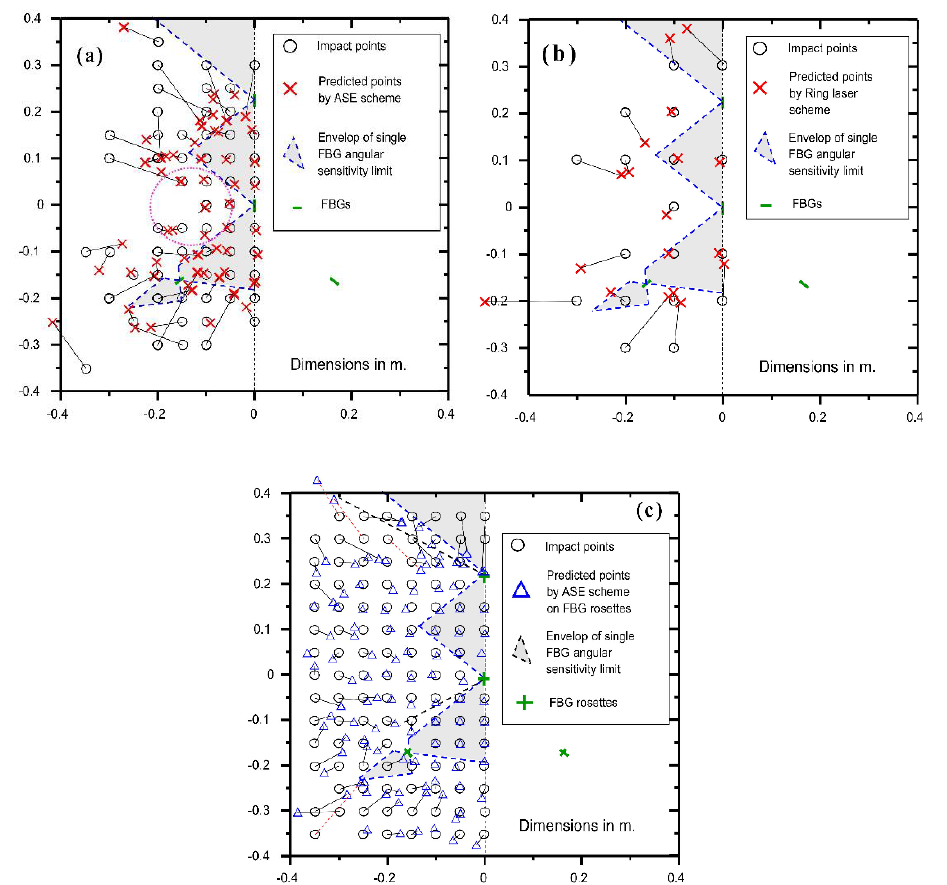
Figure 9. Comparison of the actual and deducted impact locations on the aluminum plate using ( a ) the amplified spontaneous emission (ASE) scheme / Single sensors; ( b ) the ring laser scheme / Single FBG sensors; ( c ) the ASE scheme / FBG rosette sensors.